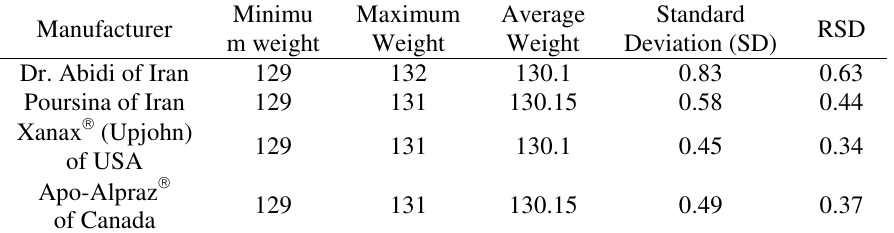
Table 4. Results obtained from weight variation measurement